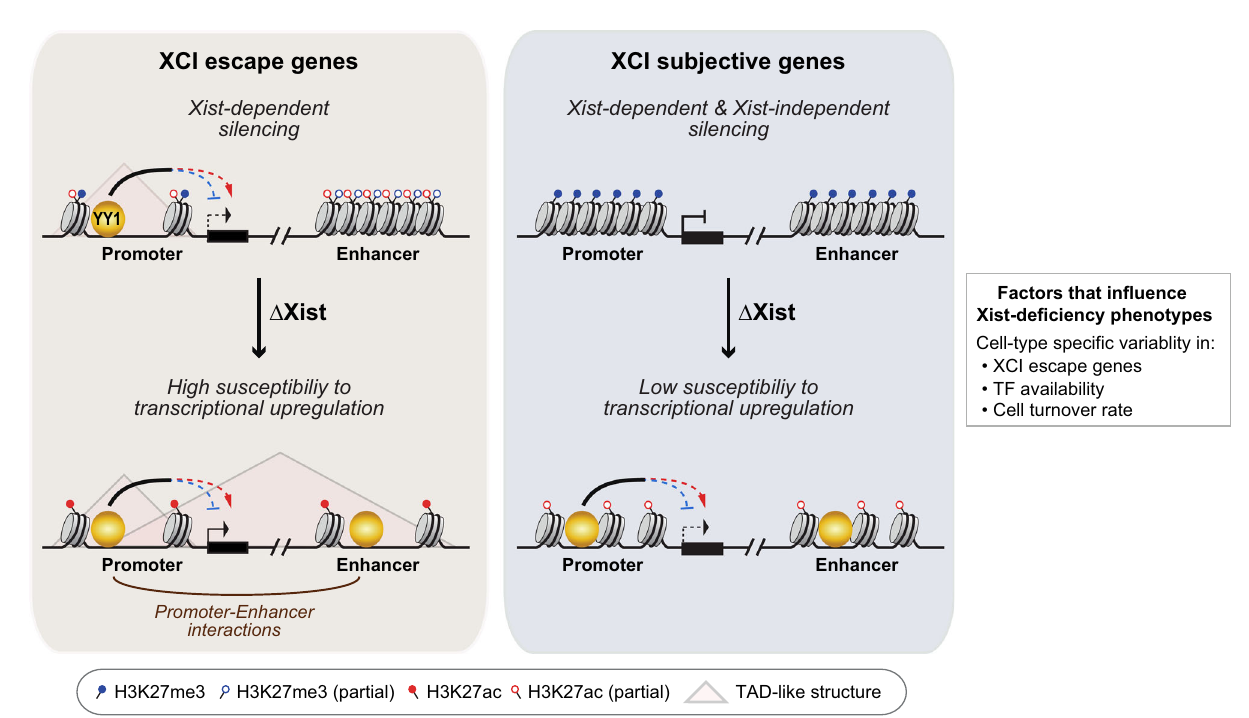
Fig. 7 | Working model on the regulatory role of Xist during XCI maintenance. Transcription of X-linked genes during XCI maintenance is regulated by Xist- dependent and Xist-independent mechanisms. Xist is required for maintaining H3K27me3 occupancy across Xi and limiting chromatin accessibility and H3K27ac deposition surrounding Xist-dependent genes. Low H3K27me3 occupancy and high chromatin accessibility at the basal state predispose XCI escape genes to be highly susceptible to transcriptional upregulation upon Xist loss. Increased chro-